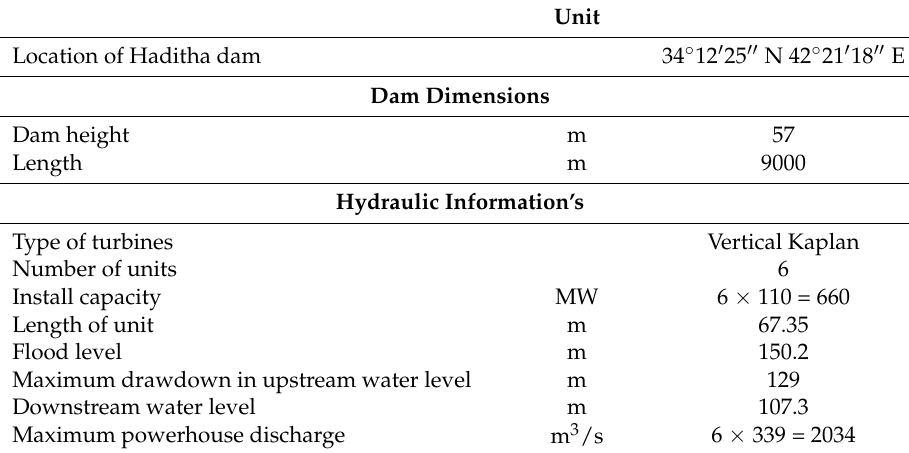
Table 1. The dimensions and hydraulic information of Haditha